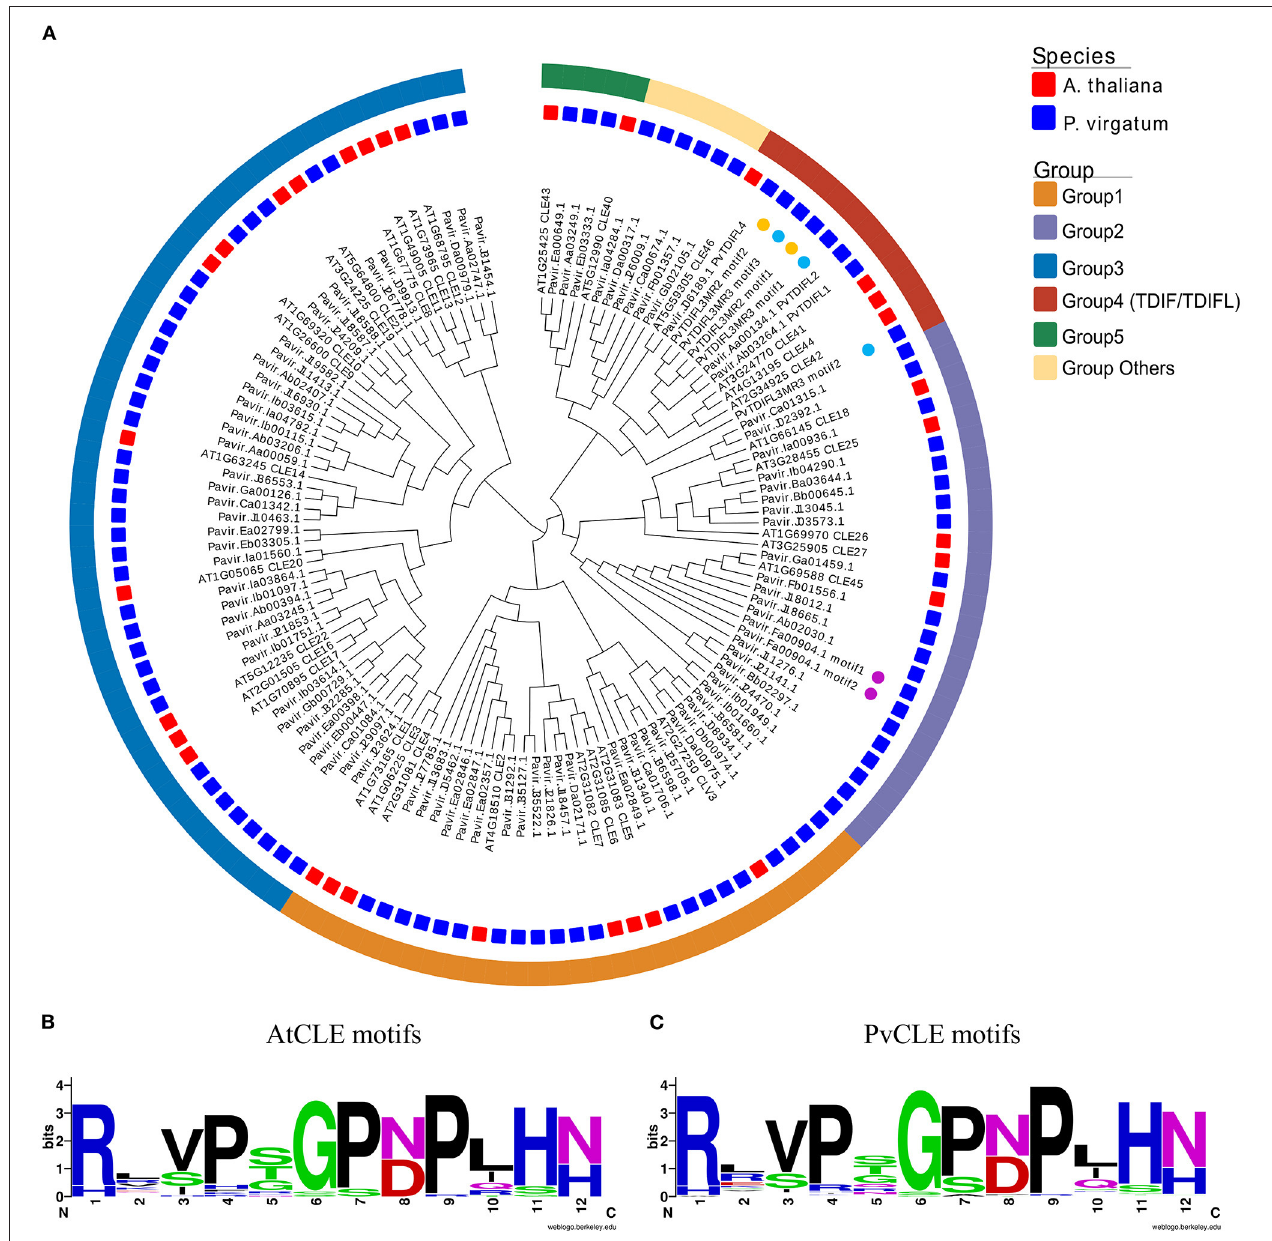
FIGURE 1 | Phylogenetics and conservation analysis of CLE genes in P. virgatum and A. thaliana . (A) Phylogeny of 12-aa motif sequences from PvCLEs and AtCLEs. The phylogenetic tree was constructed as previously described (Zhang et al., 2020). Red and blue quadrates in the middle layer indicate AtCLEs and PvCLEs, respectively. Colored boxes in the outermost layer indicate different groups; colored dots in inner layer indicate genes with multiple motifs. (B,C) Weblogo images of CLE motifs from AtCLEs (B) and PvCLEs (C) , created by using the Weblogo online tool with the amino acid sequences from CLE